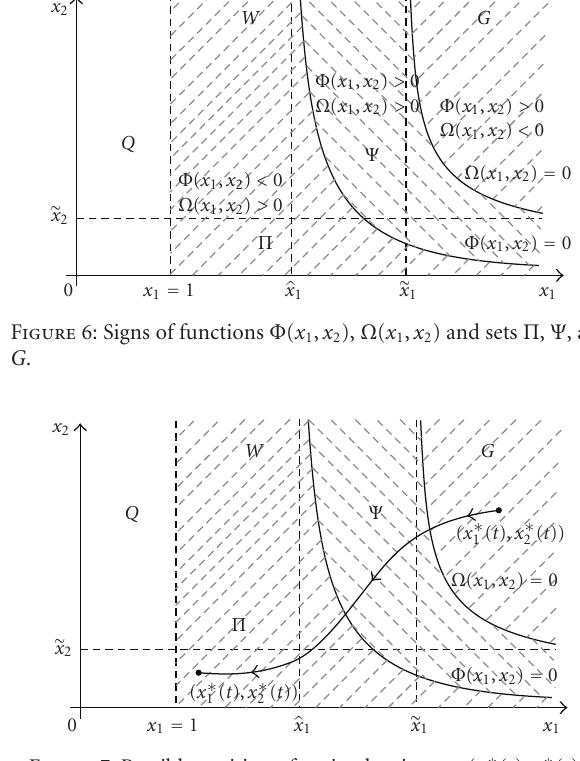
Figure 7: Possible position of optimal trajectory ( x ∗ 1 ( t ), x ∗ 2 ( t